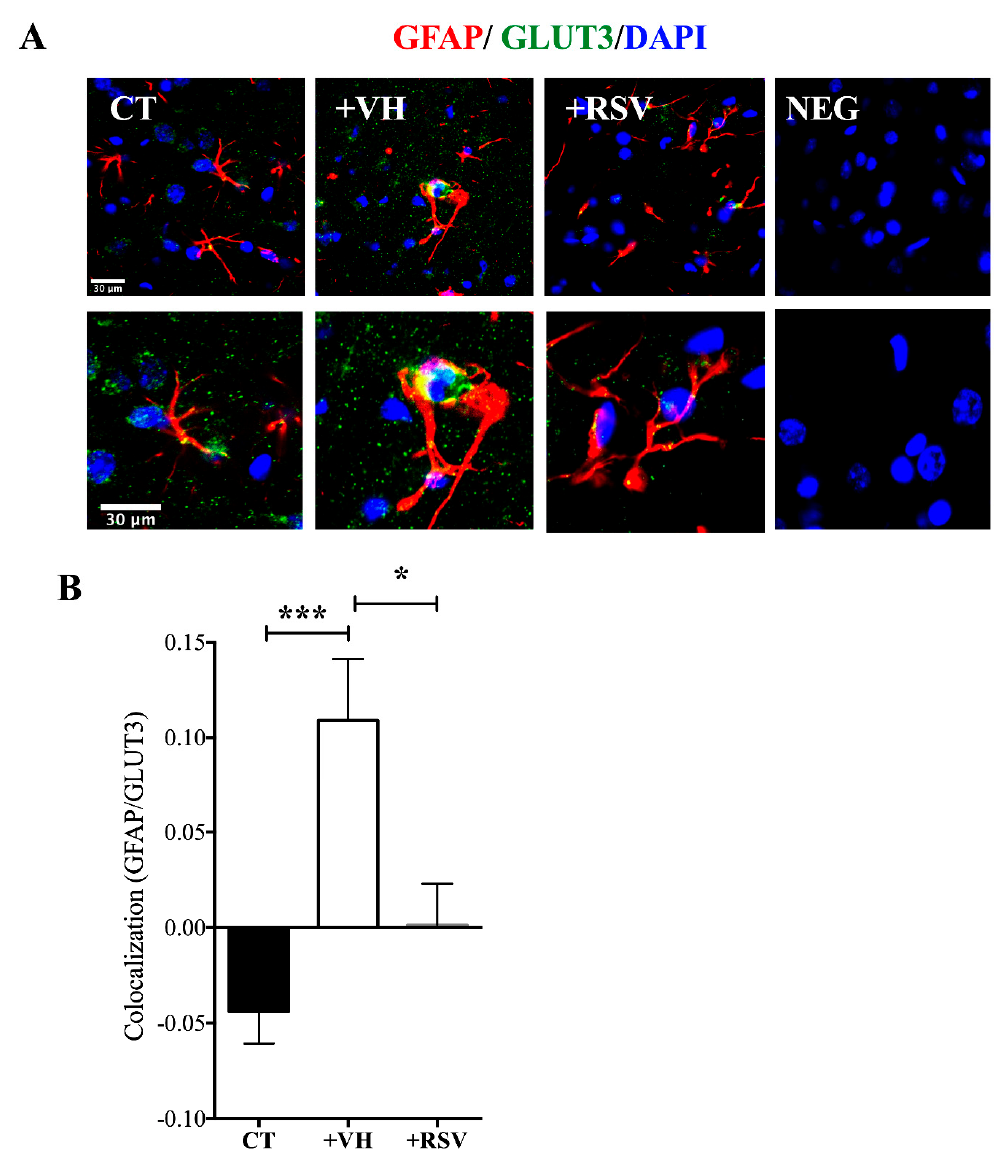
Figure 7. Resveratrol prevents the ischemia induced increase in glucose transporter 3 (GLUT3) expression. Rats were subjected to middle cerebral artery occlusion (MCAO) during 2 h followed by restoration of blood flow (reperfusion) for 24 h. Control animals (CT) were subjected to simulated MCAO. At the onset of restoration of blood flow, animals received either vehicle, ethanol 50% (+VH) or resveratrol at 1.9 mg/kg, body weight (+RSV). Immunofluorescence was used to detect GLUT3 protein expression in astrocytes. 4’, 6-diamidino-2-phenylindole (DAPI) was used to detect nuclei. ( A ) Representative images of GLUT3 (green), glial fibrillary acid protein (GFAP) (red), and nuclei (blue). ( B ) Quantification of GLUT3 expression astrocytes. Fluorescence quantification of the astrocyte (cells positive to GFAP) expressing GLUT3. Fluorescence was reported as R (Pearson’s correlation coe ffi cient) of the signal associated with the co-localization of GFAP and GLUT3 proteins in the region of interest (ROI). Values were expressed as mean ± standard deviation. ANOVA, Tukey, * p < 0.05, *** p <